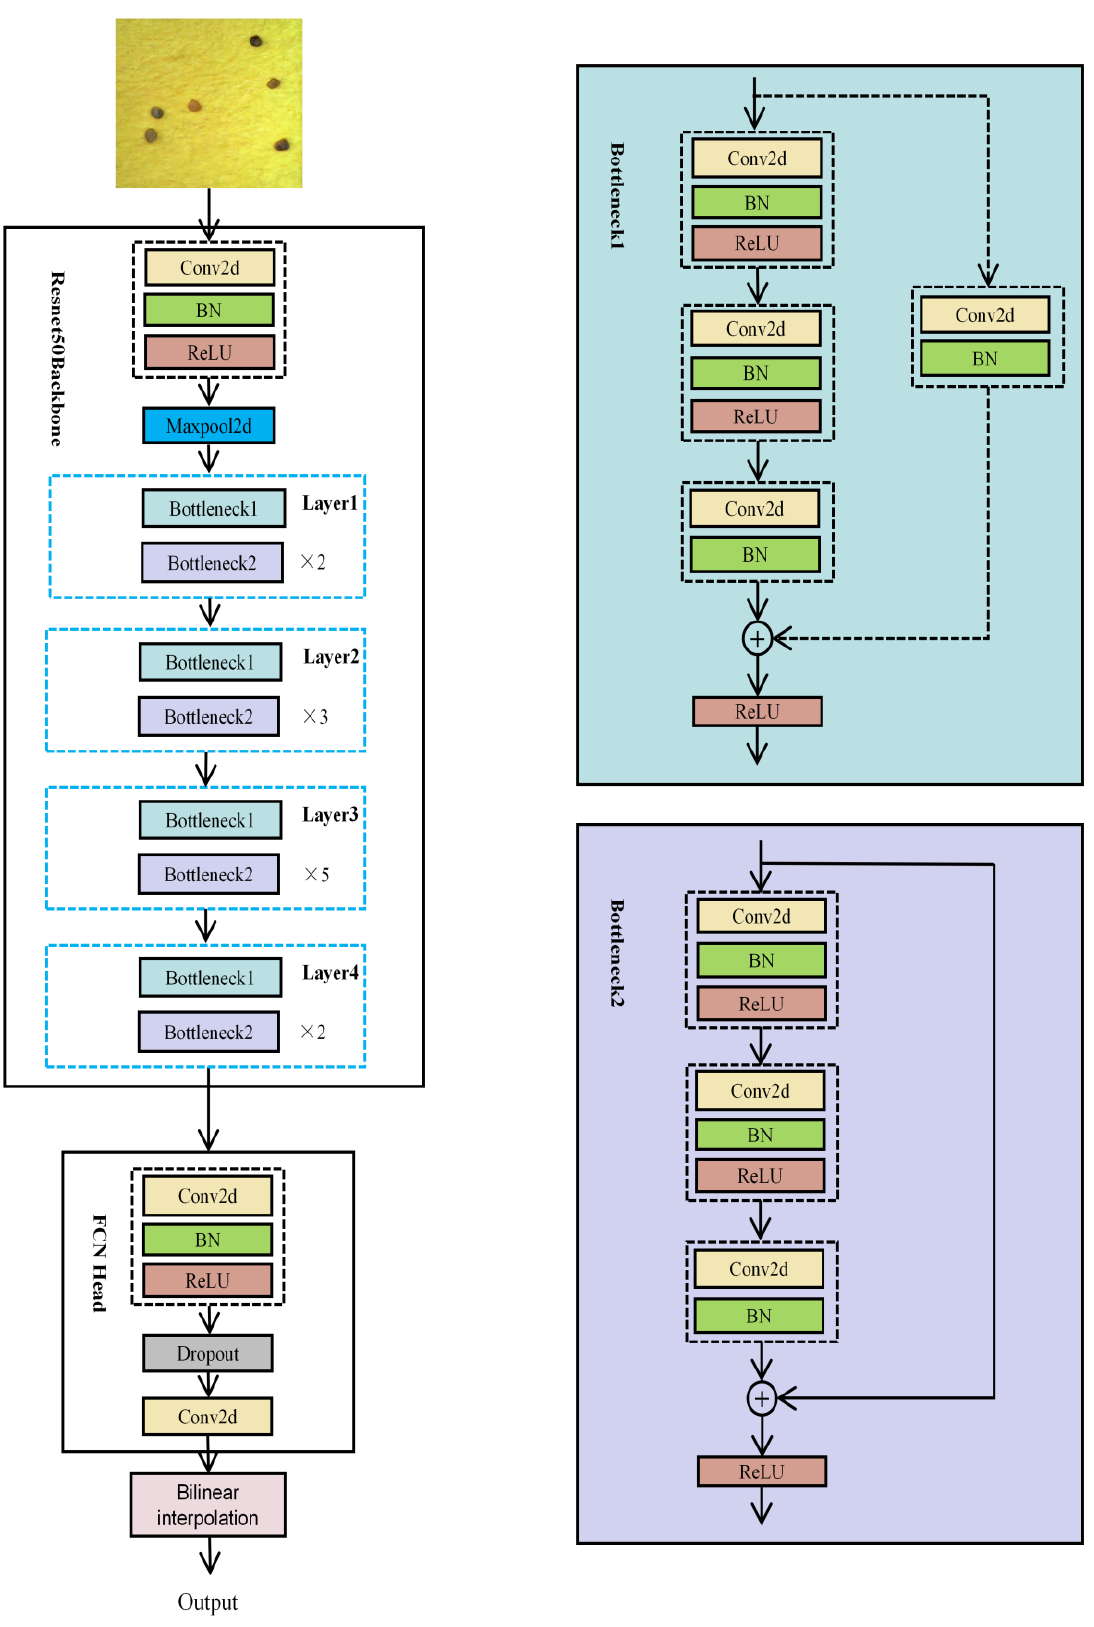
Figure 5. A diagram of FCN-ResNet50 network structure.